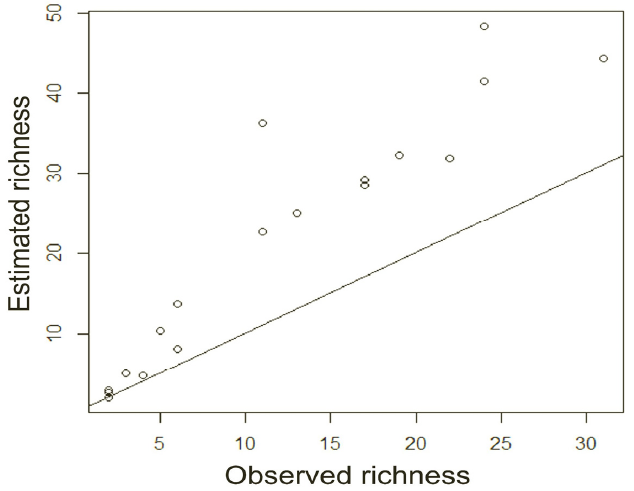
Figure 4. Observed and estimated species richness. The empty circles correspond to the sampling plots. The abundance and diversity indices (Shannon and Simpson) were found to be pos- itively and significantly correlated with species richness (Spearman, S-N, ρ = 0.798, p < 0.001; S-Shannon, ρ = 0.974, p < 0.001, S-Simpson, ρ = 0.931, p < 0.001), so that only species richness was considered in the subsequent analyses. Significant differences in mean spe- cies richness per plot were observed between the Otonga and Otongachi Reserves. The mean abundance of species and the mean number of specimens per plot are higher in Otonga (17.7 ± 2.2 species per plot, with 35.7 ± 6.1 specimens) than in Otongachi (3.4 ± 0.5 species per plot and 14.6 ± 2.7 specimens) (MW test: V = 87.5, p -value < 0.01) (Figure 5).